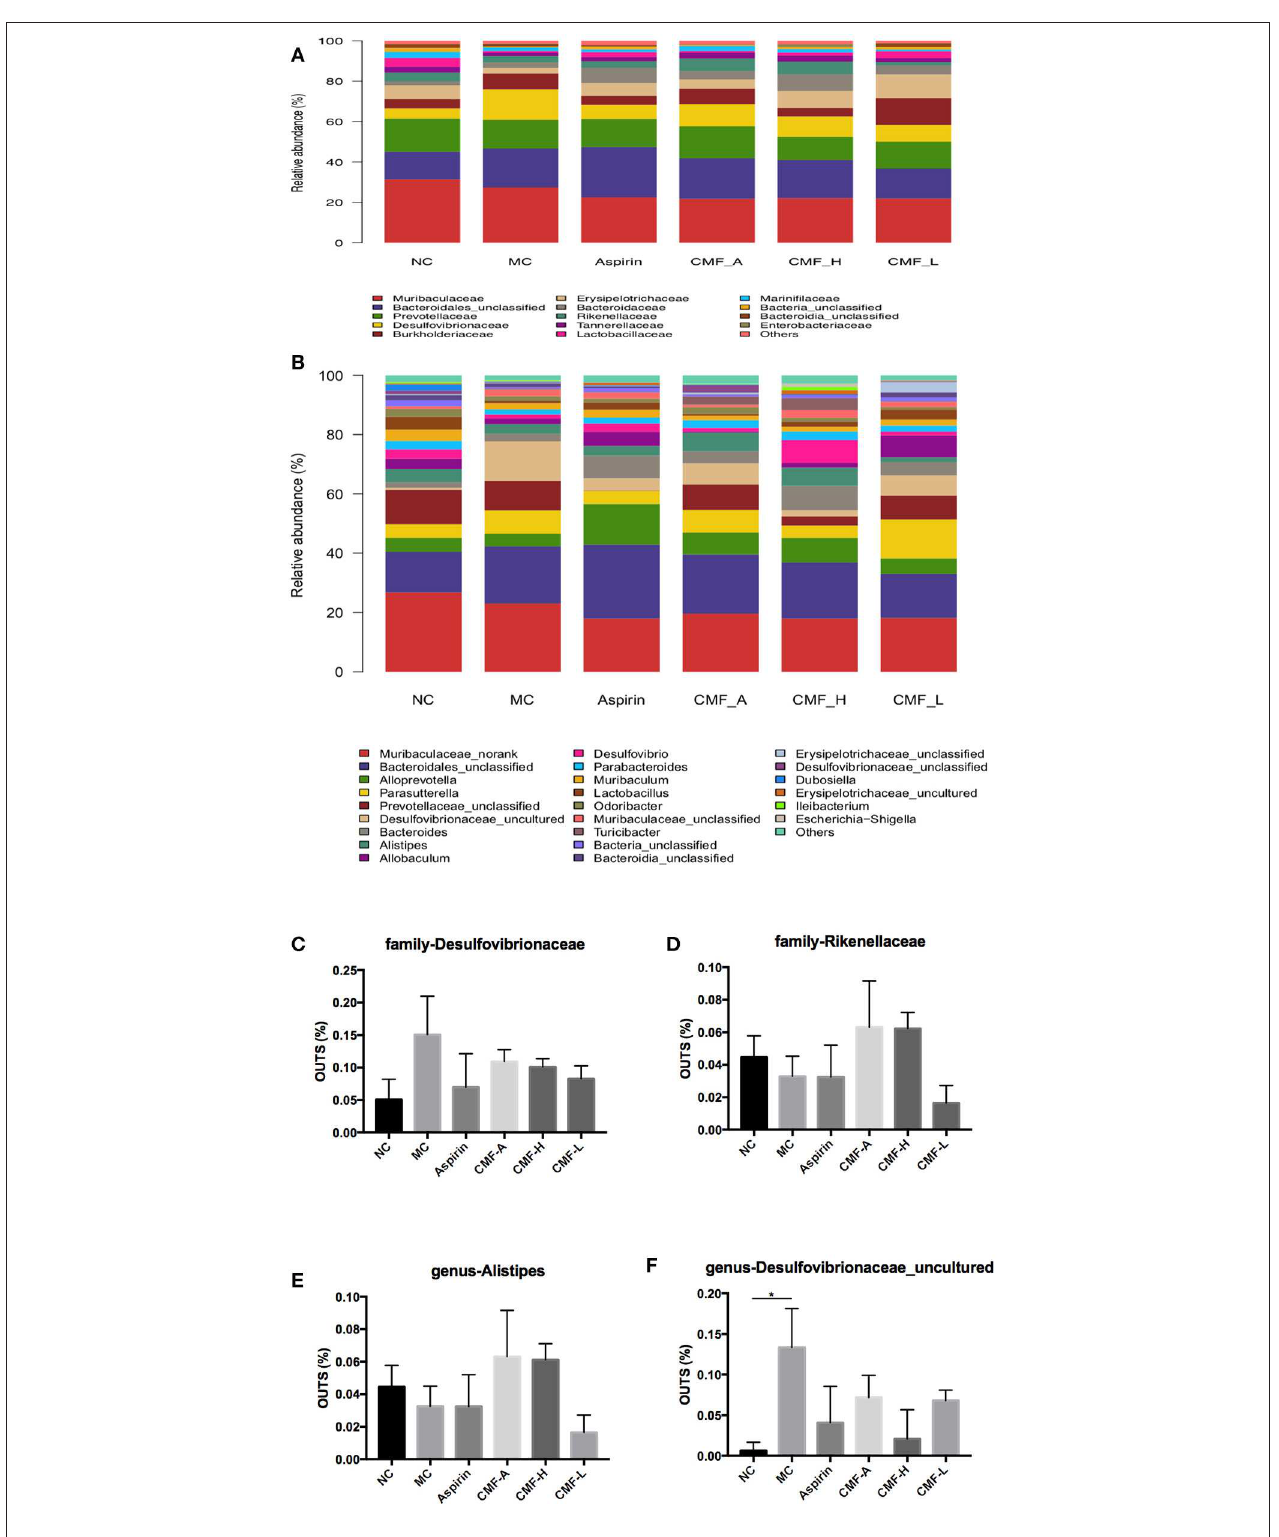
FIGURE 5 | Comparison of gut microbiota among groups. Microbiota distribution at the family level (A) and the genus level (B) . Relative abundance measured with qPCR for family-Desulfovibrionaceae, family- Rikenellaceae, and genus-Alistipes, genus- Desulfovibrionaceae_uncultured (C–F) . Superscript letters indicate statistical differences (* P <